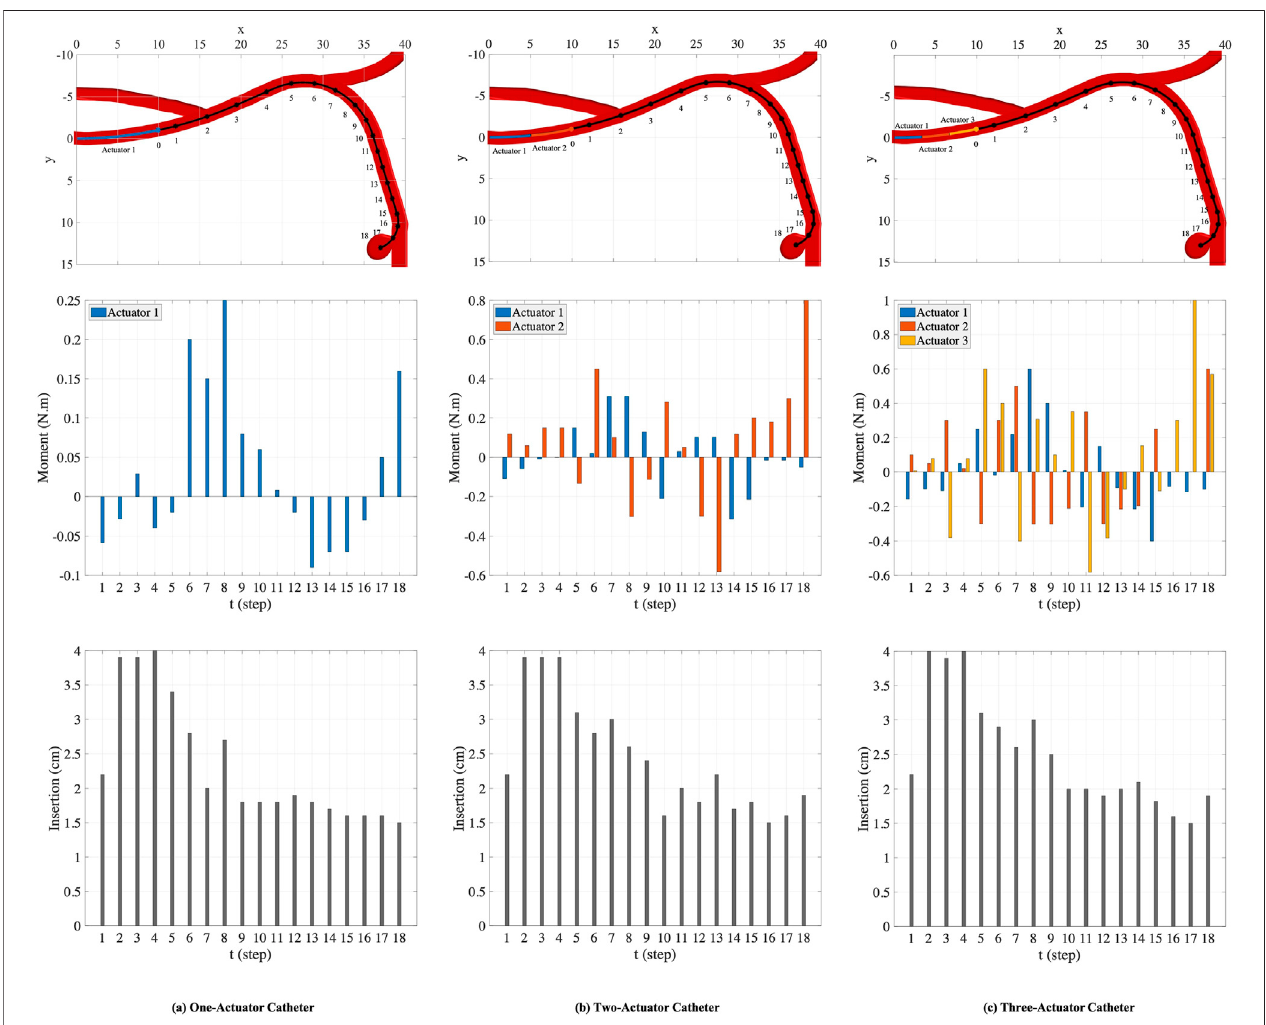
FIGURE 7 | The nominal trajectory and the points generated on the trajectory (top row) . The moments (middle row) and the insertion depths (bottom row) applied by one-actuator, two-actuator, and three-actuator catheters in 18 steps.